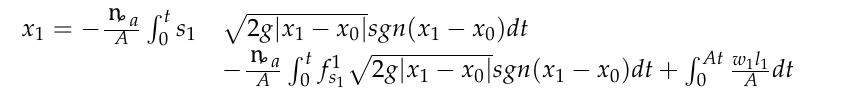
Figure 1. Three-pond hydraulic